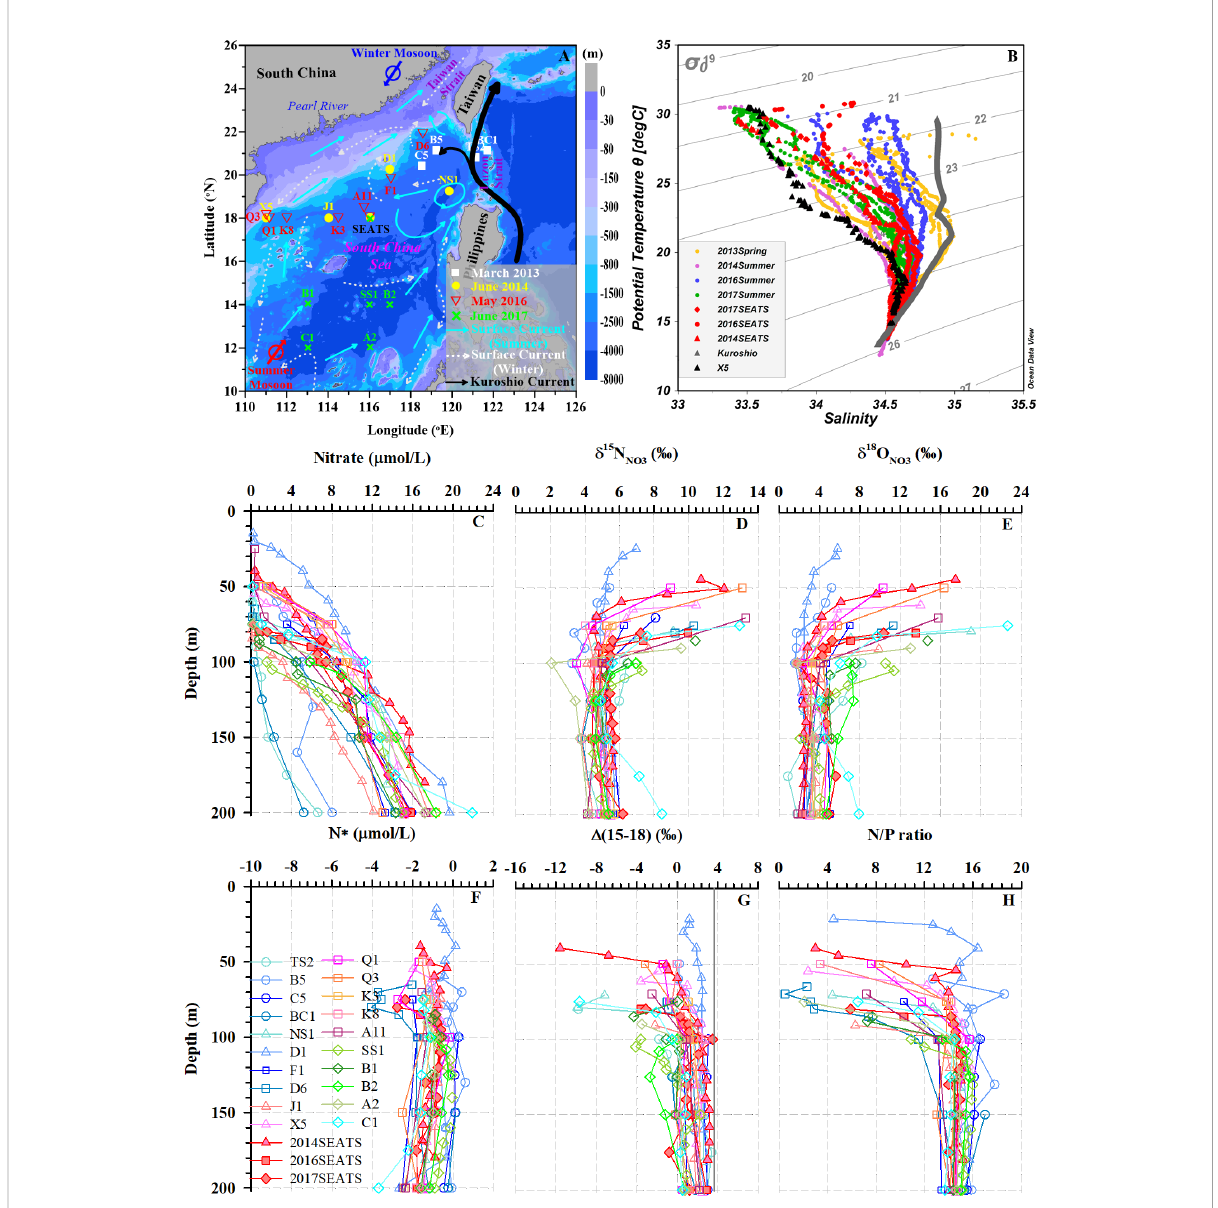
FIGURE 1 (A) Study area and sampling stations in the SCS. Surface circulation patterns are shown with arrows synthesized from previous studies (Yuan et al., 2006; Nan et al., 2015; Liu et al., 2016): summertime surface currents (cyan), wintertime surface currents (white dashed), and the Kuroshio Current (black). The color bar indicates water depth. (B) Potential temperature-salinity diagram for all stations. The red and black triangles indicate typical SCS water and coastal water, respectively. The gray triangles represent the Kuroshio Current. (C – H) Depth and isopycnal pro fi les for all samples with NO 3 – concentrations ≥ 0.5 m mol/L: NO 3 – concentrations (C) , d 15 N NO3 (D) , d 18 O NO3 (E) , N* (F) , D (15-18) (G) , and N/P ratio (H)